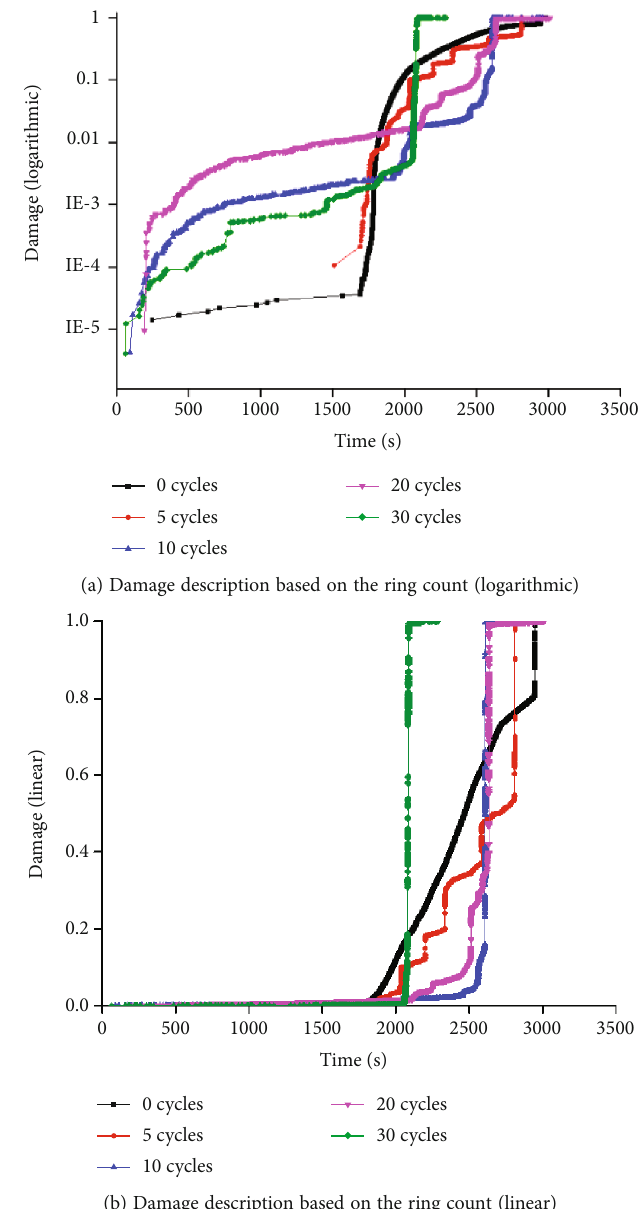
Figure 9: Variation in sandstone uniaxial compression damage with the number of freeze-thaw